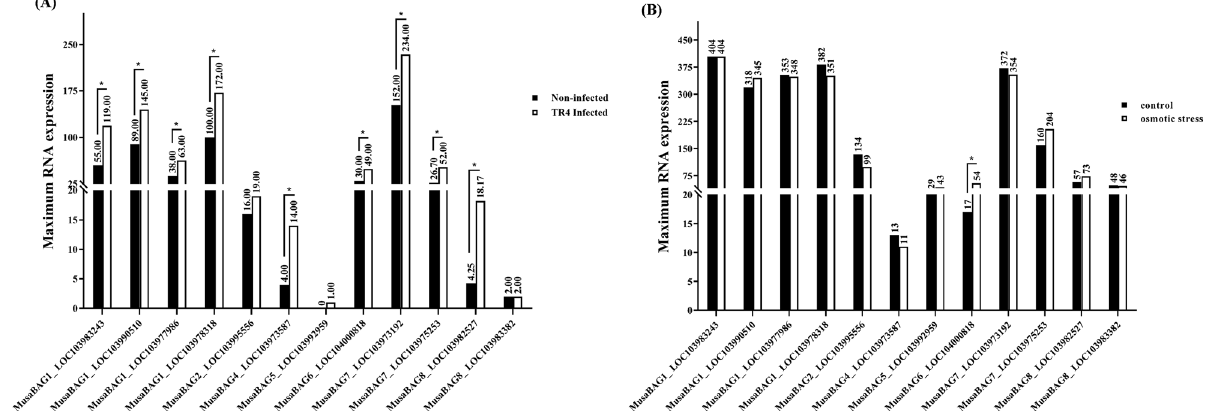
Figure 6. Relative expression profile of MusaBAG genes in biotic and abiotic stresses using the RNA-seq data of Musa acuminata DH-Pahang (AA) available in the banana genome hub. ( A ) Expression levels of MusaBAG genes inoculated with Fusarium oxysporum f. sp. cubense tropical race 4 (Foc TR4, now Fusarium odoratissimum ) depicted in white bars with respect to the uninfected control (depicted as black bars) showed significant upregulation of MusaBAG1, 4, 6, 7 and 8 at P < 0.05 ( B ) The expression levels of MusaBAG genes under osmotic stress condition (depicted as white bars) showed no significant difference except MusaBAG6 at P < 0.05, as compared to the unstressed control plants (depicted as black bars).